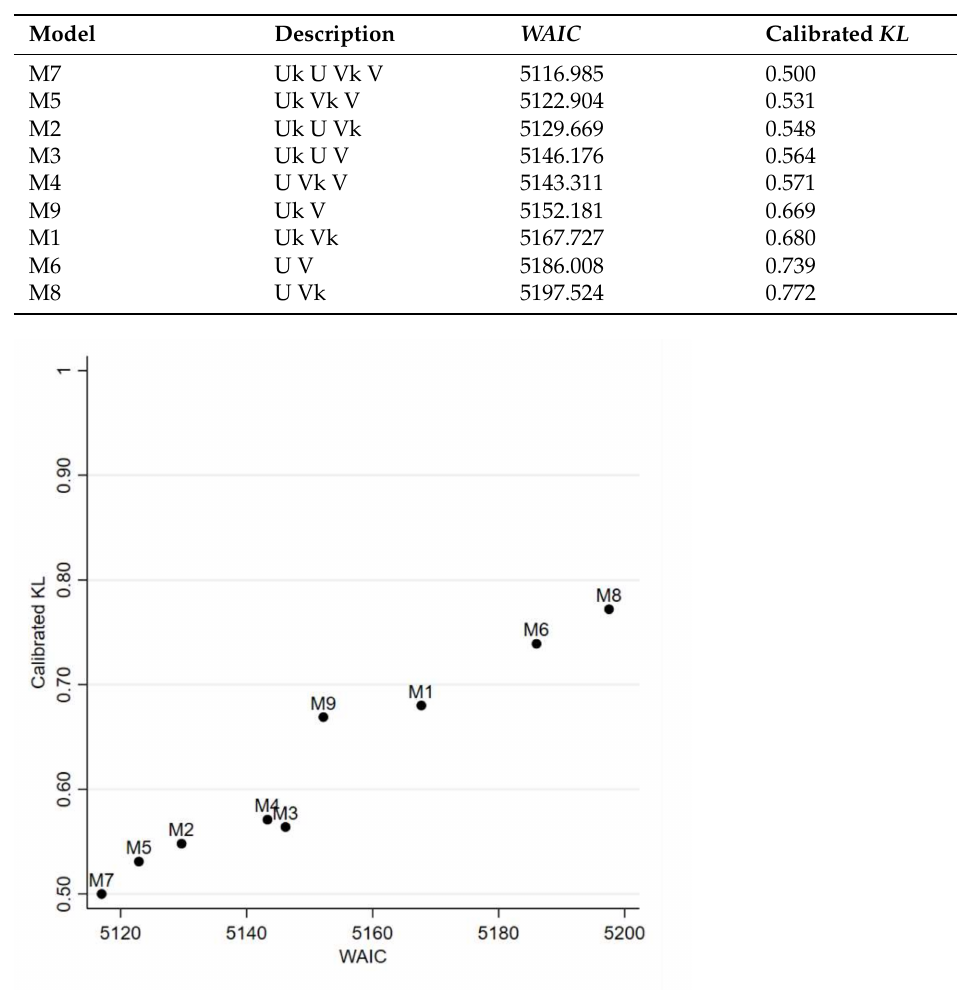
Table 3. WAIC and median calibrated Kullback–Leibler divergence (Calibrated KL ) for all the fitted models.